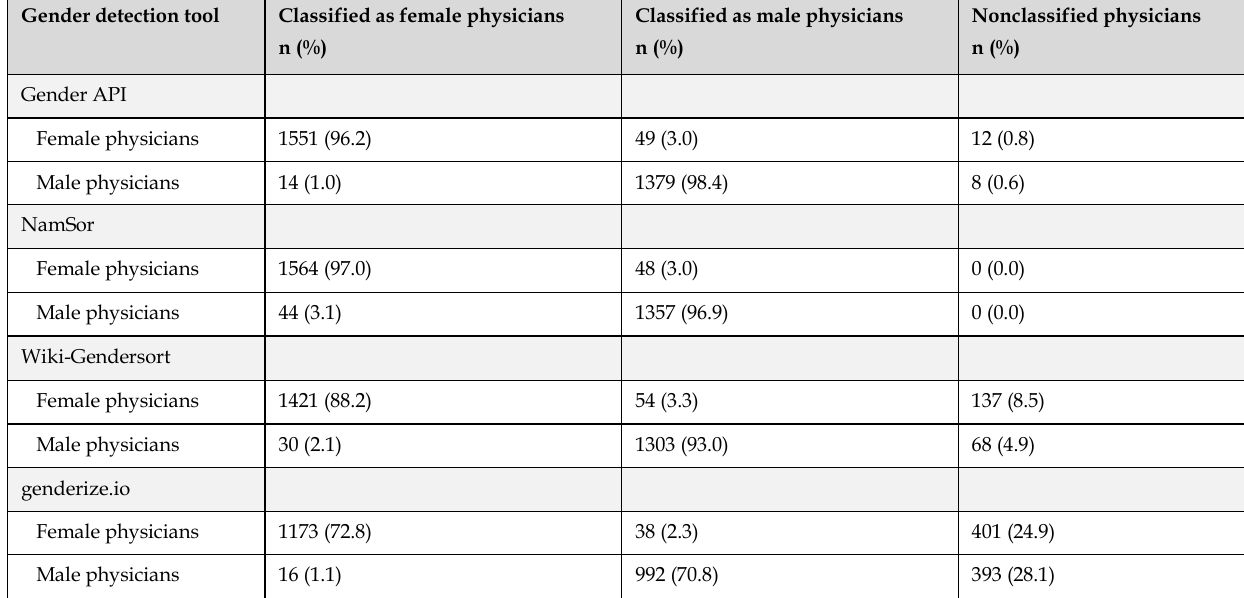
Table 3 Confusion matrices for gender detection tools after removing duplicates (i.e., physicians with identical first names and gender) (n=3,013 physicians) Gender detection